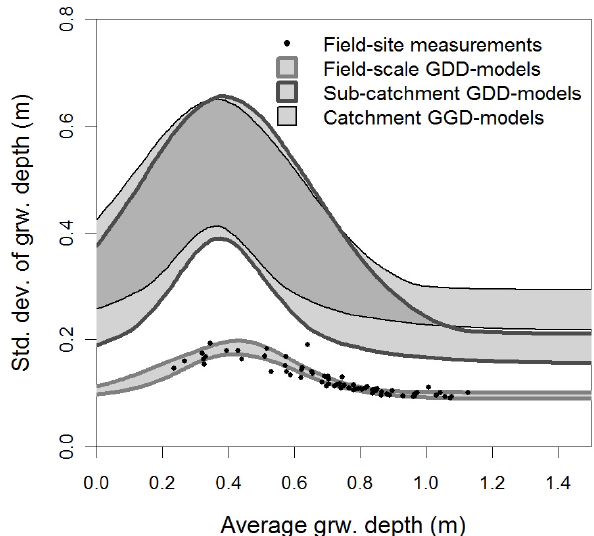
Fig. 7. Bandwidth of behavioral GDD-curves for the three scales of the nested-scales model (BPS-N). The dark grey area indicates overlap between ensembles of